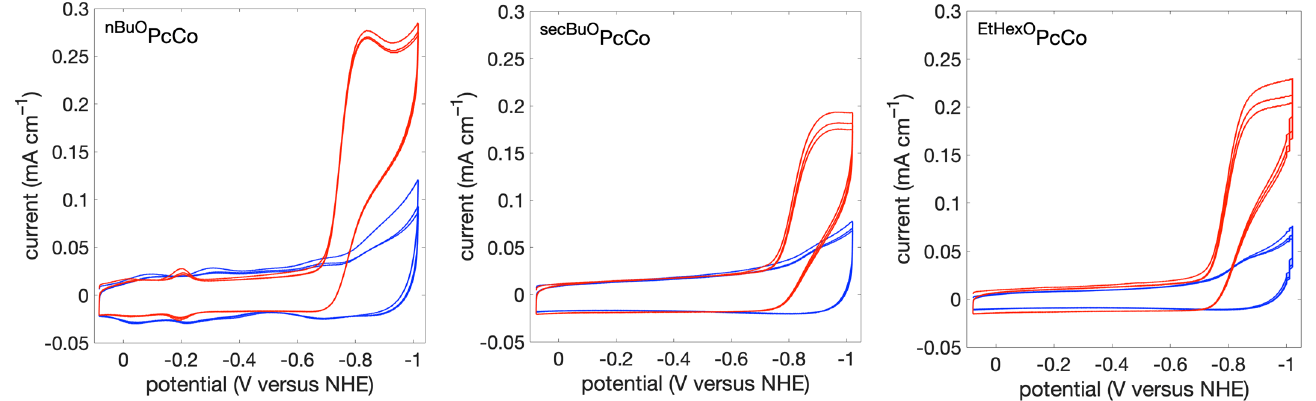
Figure 2. Representative cyclic voltammograms of drop cast RO PcCo under 1 atm argon (blue) and under 1 atm CO 2 (red). Traces were recorded at 100 mV s – 1 . The deposited concentrations were 1 mM ( nBuO PcCo), 0.18 mM ( secBuO PcCo), and 0.18 mM ( EtHexO PcCo).